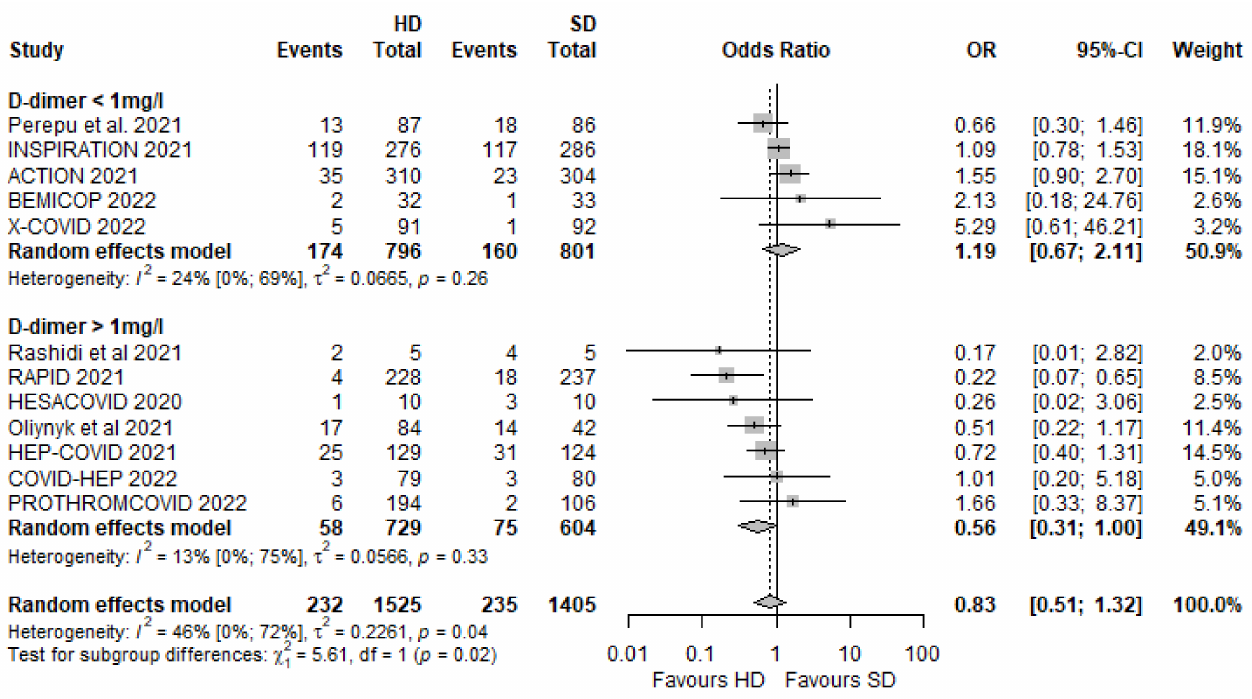
Figure 3. All-cause mortality in cohorts with different baseline D-dimer levels